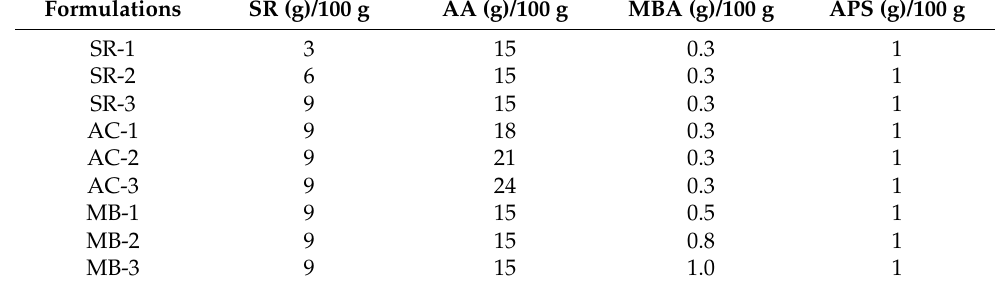
Table 6. Hydrogels prepared with different concentrations of sericin, acrylic acid (AA), and MBA. Formulations